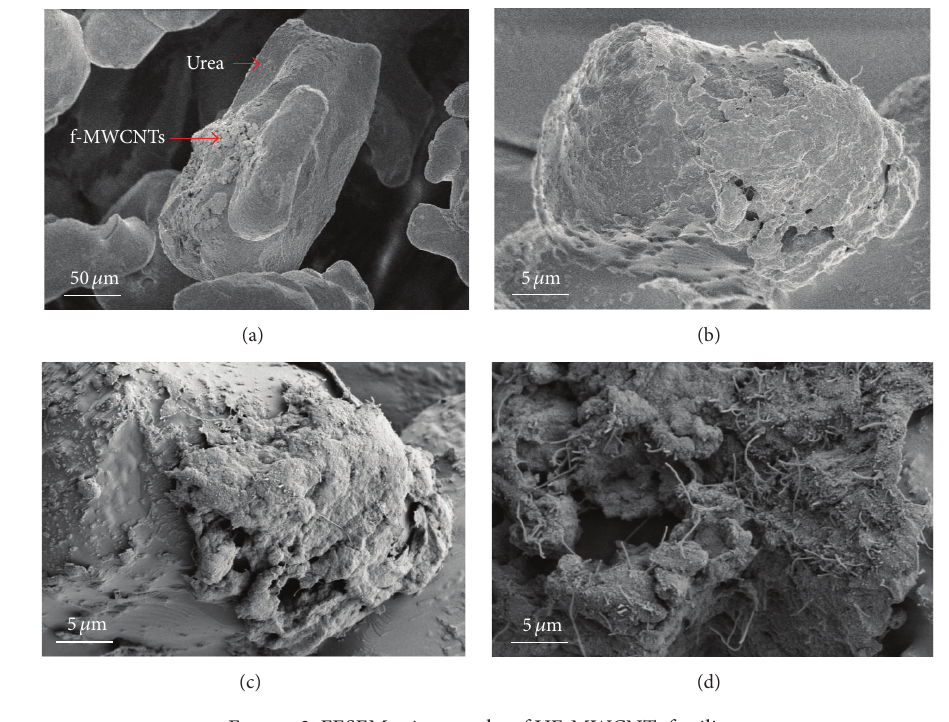
Figure 2: FESEM micrographs of UF-MWCNTs fertilizer.